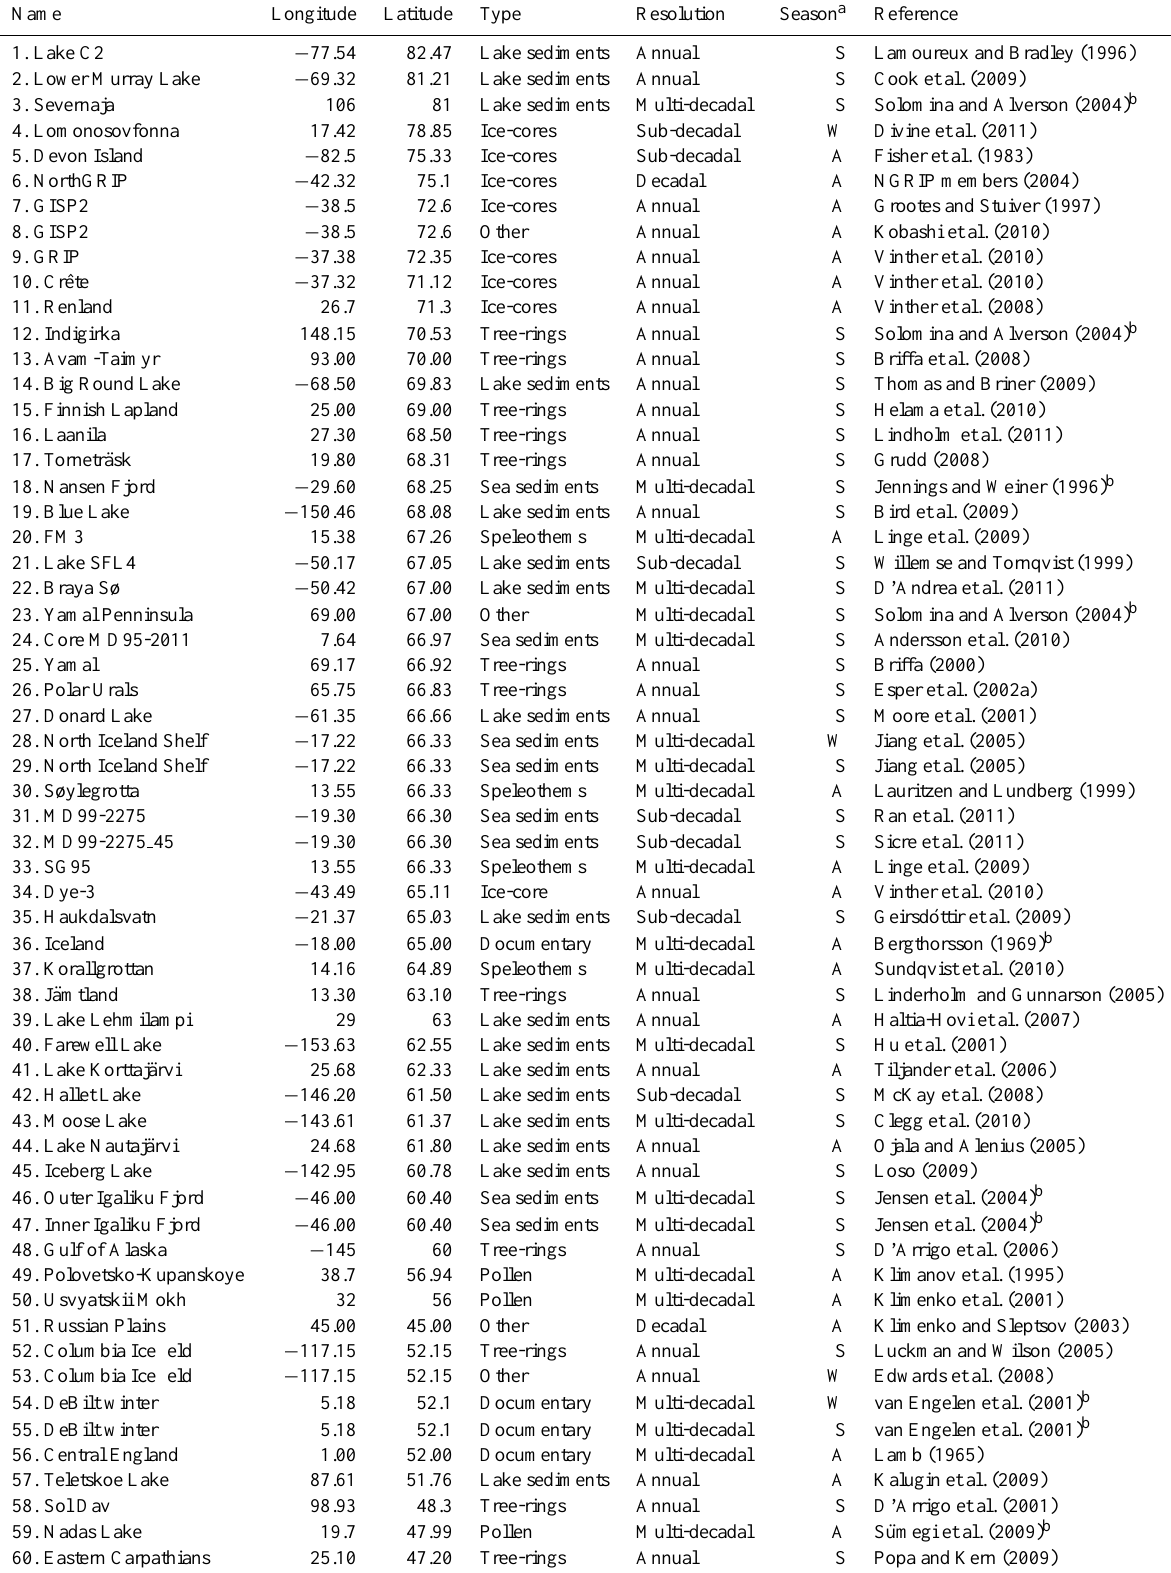
Table A1. All proxy records used in this study listed in geographical order from north to